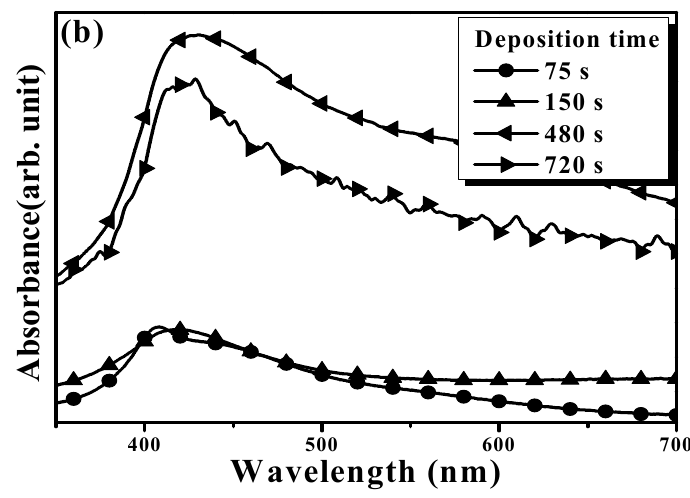
Figure 3. ( a ) Optical transmittance; and ( b ) absorbance spectra of the annealed Ag seed layers as a function of the deposition time.